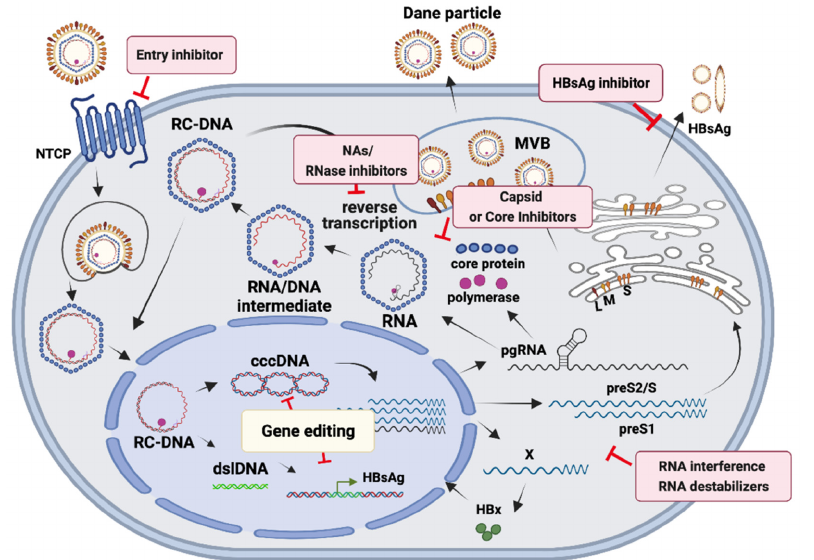
Figure 1. HBV life cycle and current drugs and drugs in development for CHB. The current and candidate antiviral drugs are shown in rectangle box and the targets of inhibitory mechanisms are pointed out by a T-shaped blocking sign.